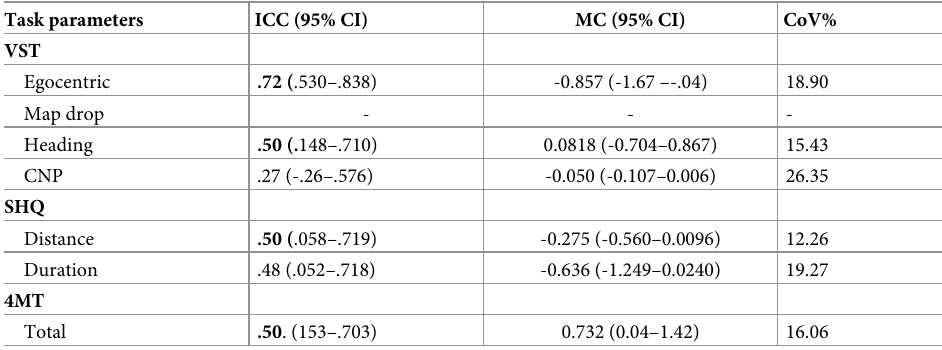
Table 3. Intra-class correlations coefficients, mean change, and coefficient of